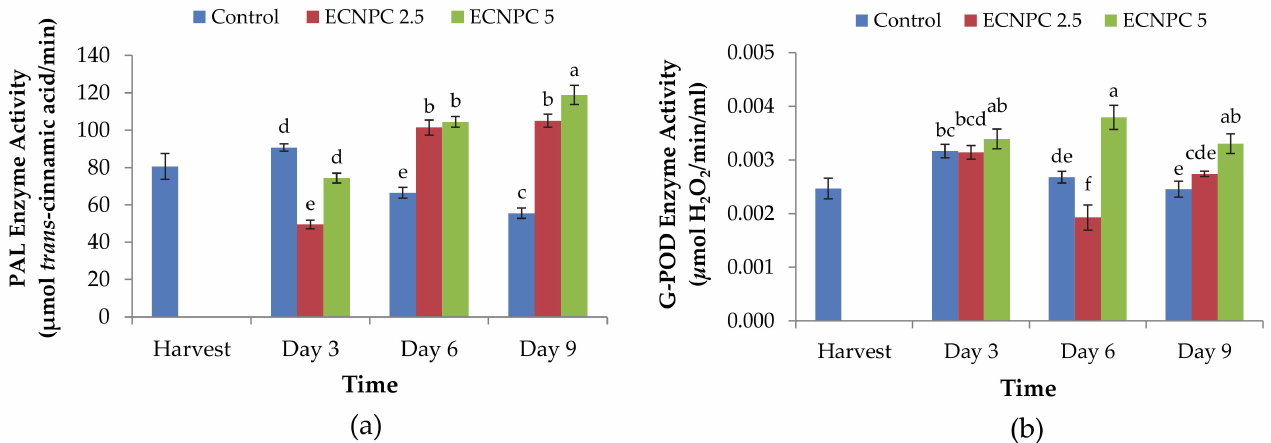
Figure 5. Effect of chitosan nano-emulsion coatings (at 0 g L − 1 , 2.5 g L − 1 , and 5 g L − 1 ) on antioxidant activity: ( a ) pheny- lalanine ammonia-lyase (PAL) enzyme activity and ( b ) guaiacol peroxidase (G-POD) enzyme activity of raspberries stored for 9 d (at 4 ± 1 ◦ C with 90–95% RH). Control refers to untreated raspberries. The data shown are the mean ± standard error of four replicates. Different letters indicate statistical significance ( p <